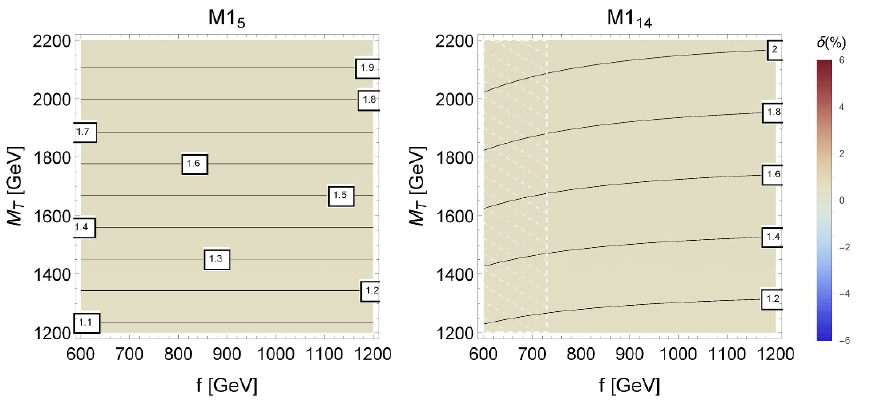
Figure 15 . The contour plots of (cid:14) ( p cut ) with sin 2 (cid:18) L = 0 : 025 and p cut = 200 GeV for the singlet T T models with one top partner multiplet. The corresponding values of y are indicated by the solid lines. The region marked by dashed white lines indicates when (cid:20) t (cid:20) 0 :